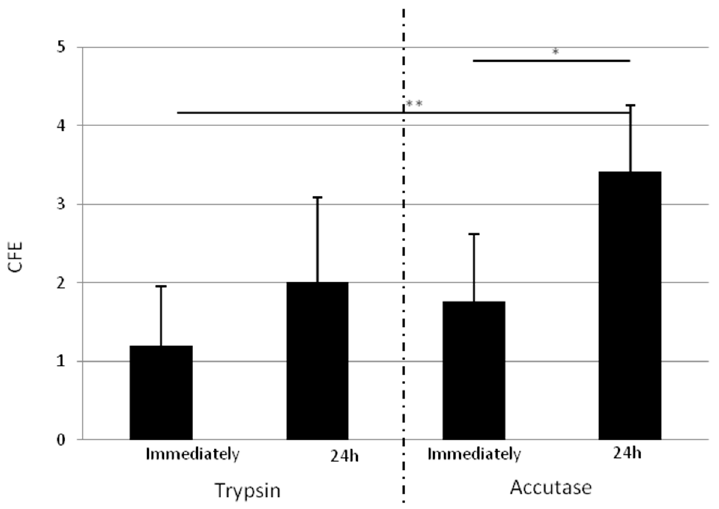
Figure 5. Influence of detachment method on clonogenic potential of RA cells. CFE obtained for RA cells immediately detached or 24 h after adhesion, with trypsin (TE) or accutase (Ac). Results obtained by the two dissociation reagents are separated by the dotted line. Detaching cells 24 h after adhesion with accutase allows for obtaining a better clone number. Mean of three donors. n = 3. * data significantly different ( p < 0.05), ** p < 0.005.